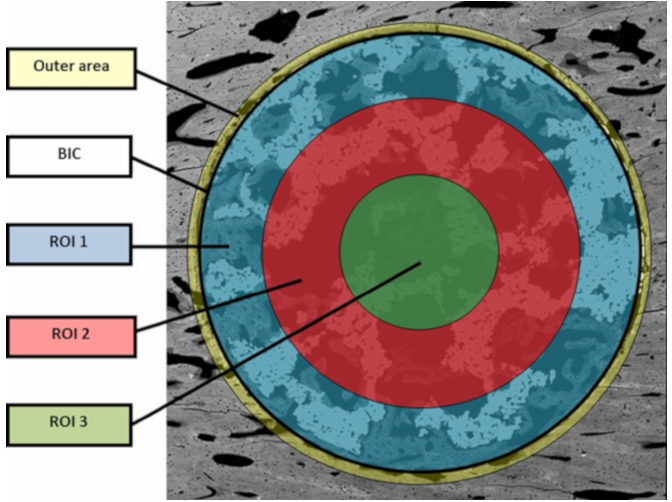
Figure 10. Graphical scheme for assessment of BIC and ROI